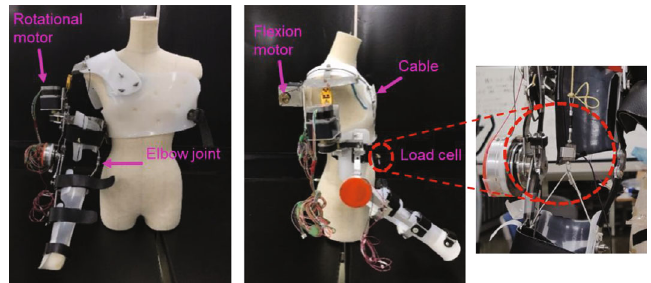
Figure 1: The overview of the developed wearable assistive device [22] and the load cell position for tension force measurement.